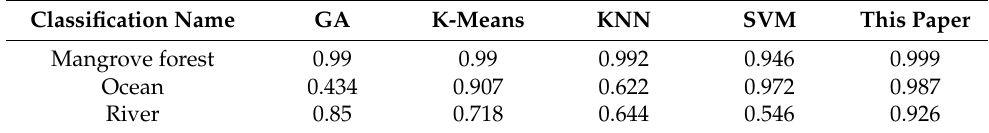
Table 5. Test Results for Accuracy (P) Parameter (Data 2).